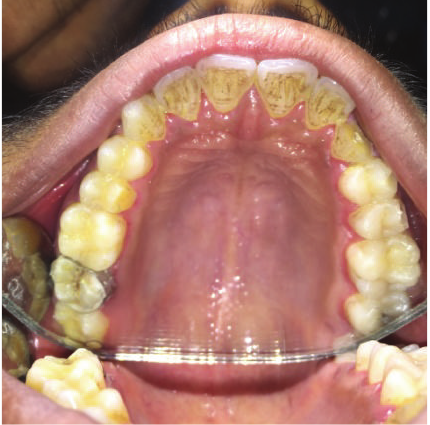
Figure 10: Photograph showing stabilization of split tooth with respect to 27 using orthodontic band.